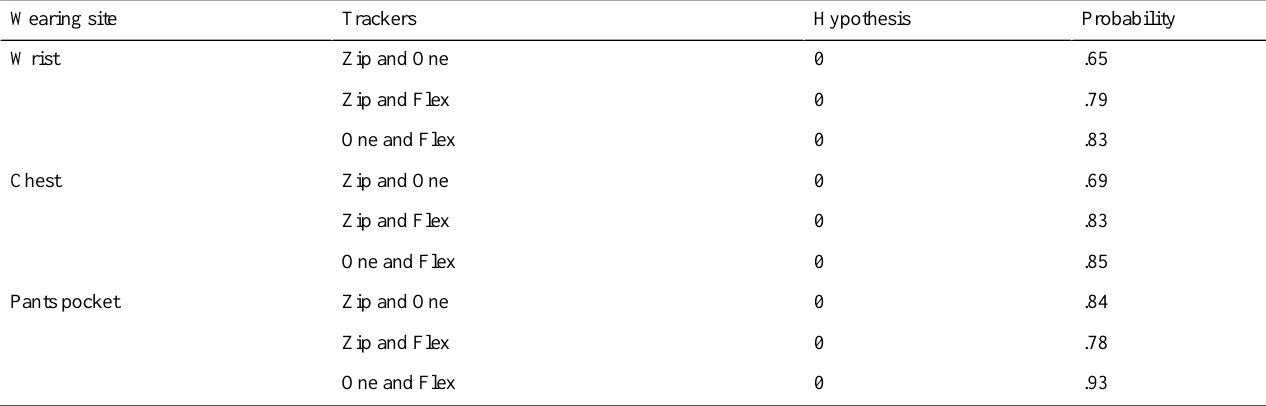
Table 2. t test results on the number of the steps different Fitbit trackers count when used on the same wearing